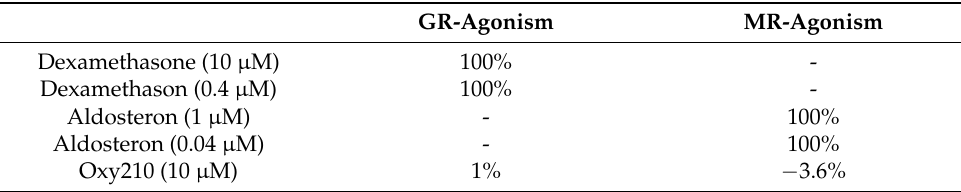
Figure 12. Effects of Oxy210 on COX1 and COX2 enzyme activities. The reactions were performed as described in Materials and Methods using the compounds as indicated. Data are reported as the mean of triplicate determinations ± SD. Table 2. Effect of Oxy210 on glucocorticoid (GR) and mineralocorticoid receptor (MR) activity. The GR and MR activity assays were performed as described in Materials and Methods using the compounds as indicated. Dexamethasone and aldosterone were used as positive controls for GR and MR,